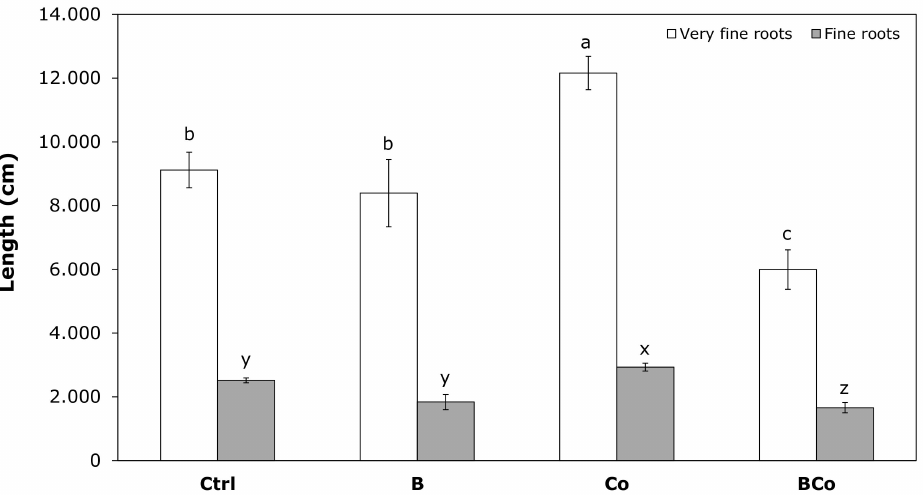
Figure 6. Length (cm) of very fine roots (0 < d < 0.5 mm) and fine roots (0.5 < d < 2 mm) (white box, very fine roots; gray box, fine roots) determined after 12 months of P. euramericana growth on four different substrates (Ctrl, B, Co, and BCo). Different letters indicate a significant difference among substrates ( p < 0.05) ( n = 3 ± SE). Letters a, b, c regard very fine roots; letters x, y, z regard fine roots. Ctrl: control mix of soil and sand; B: mix of soil and sand + biochar; Co: mix of soil and sand + compost; BCo: mix of soil and sand + biochar +